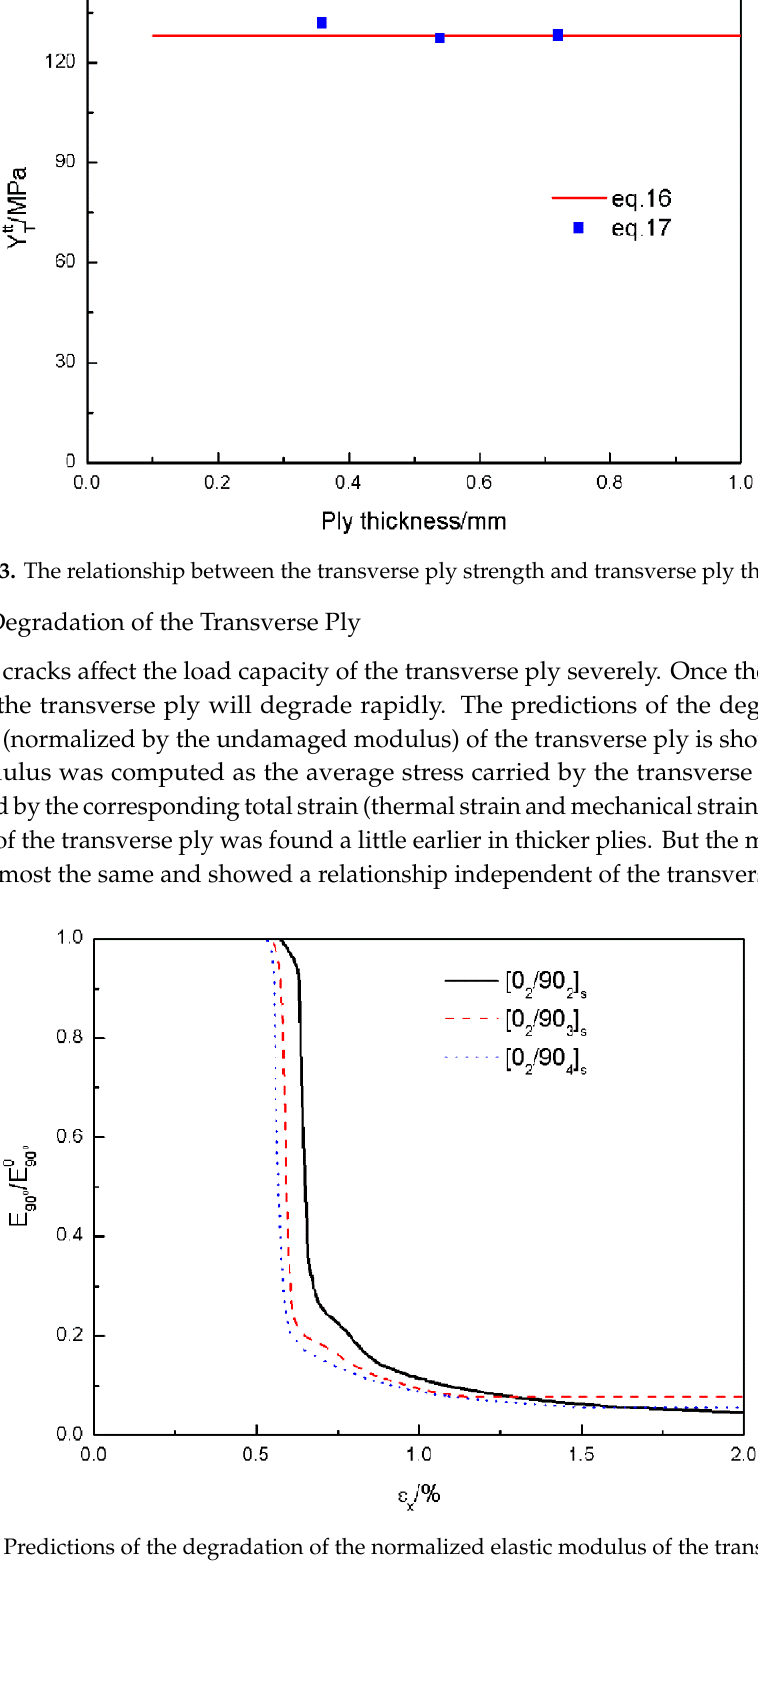
Figure 14. Predictions of the degradation of the normalized elastic modulus of the transverse ply.